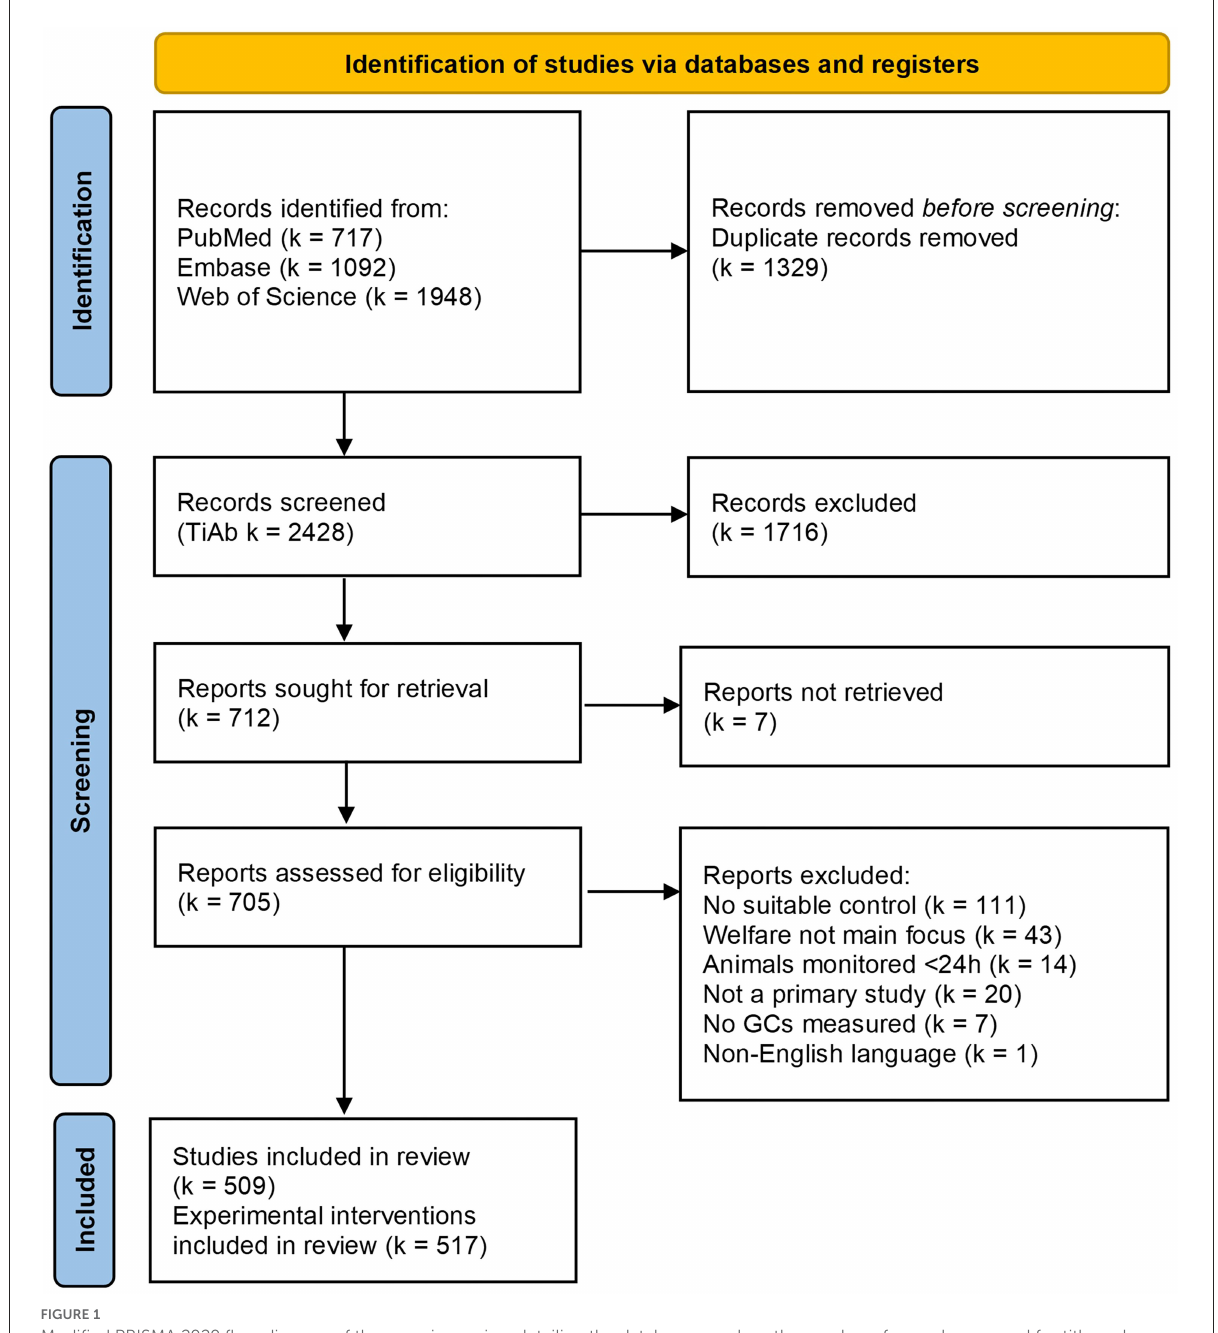
FIGURE1 Modified PRISMA 2020 flow diagram of the mapping review detailing the database searches, the number of records screened for title and abstracts (TiAb) and full-text, and the final number of studies ( n ) and experiments [k] included for data extraction. Figure adapted from Page et al.